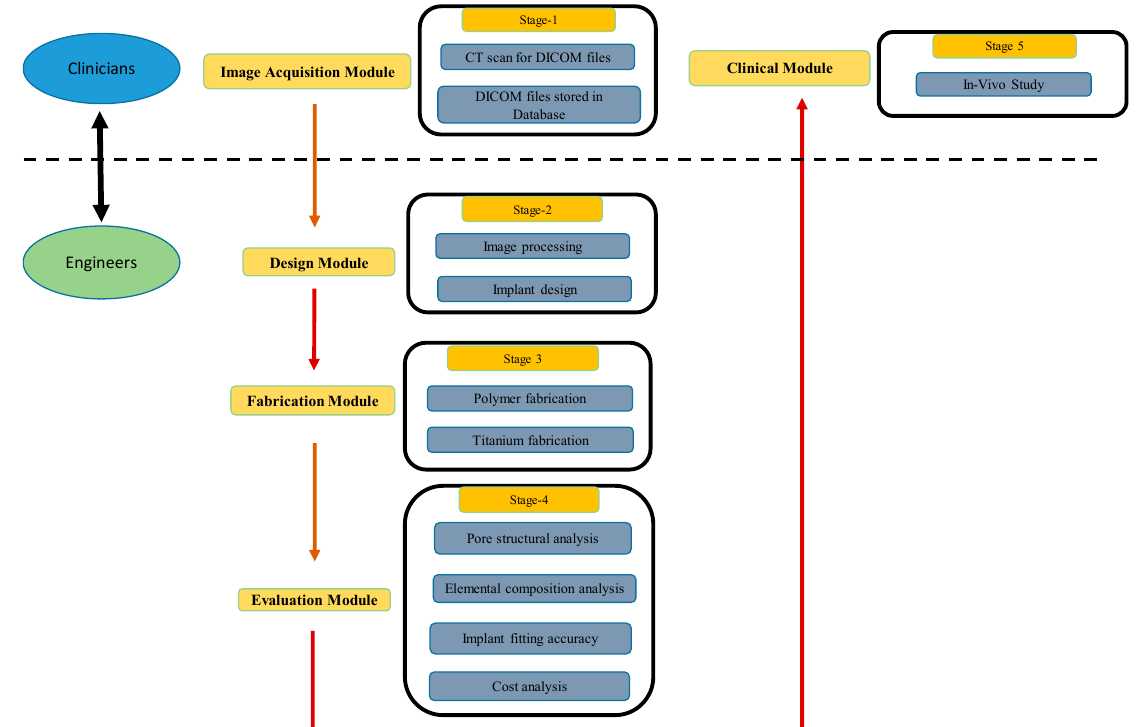
Figure 1. Research methodology for qualified implant consisting of five modules.